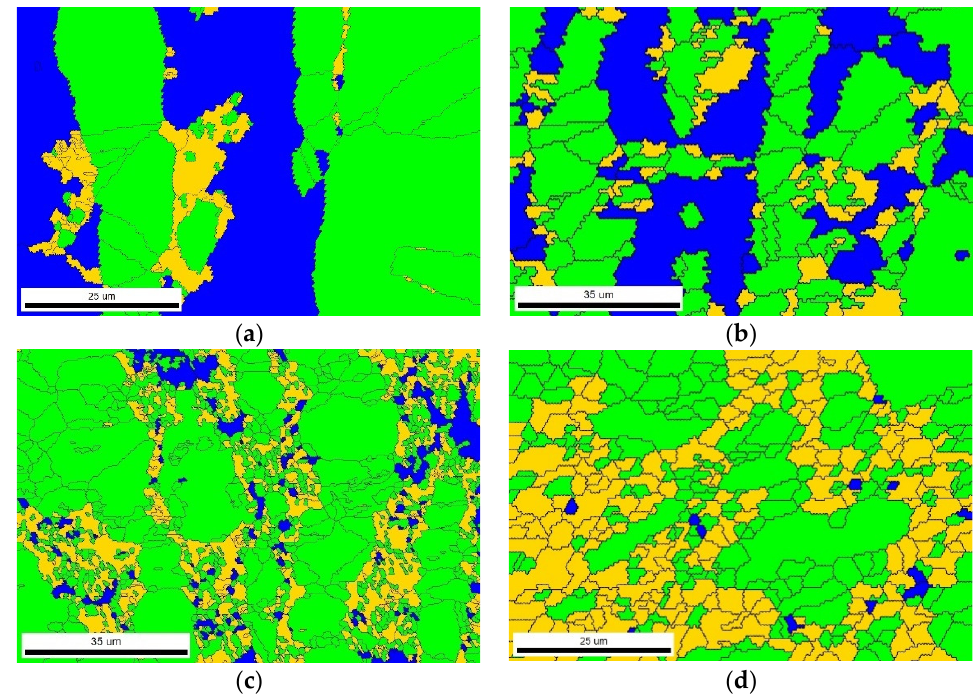
Figure 7. Phase maps of the samples with a rolling reduction of 0% ( a ), 22.3% ( b ), 41.6% ( c ), and 61.9% ( d ), and heat treatment of 850 °C for 30 min: blue, ferrite; green, austenite; yellow, sigma phase. According to the EBSD measurements, the sigma-phase content of the specimens increased with increasing rolling reduction while the ferrite content decreased. The obtained volume ratio of the sigma phase is shown in Table